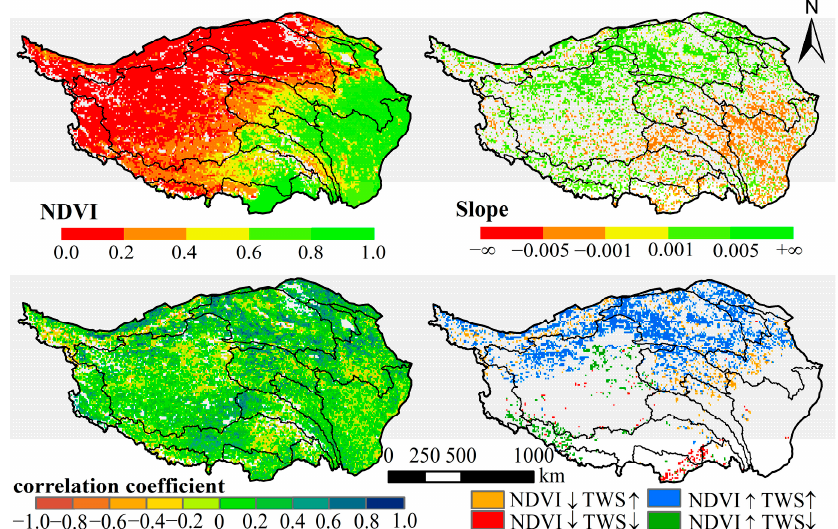
Figure 12. Characteristics of the underlying surface and its relationship with terrestrial water storage over the Tibetan Plateau during the period 1981–2015.